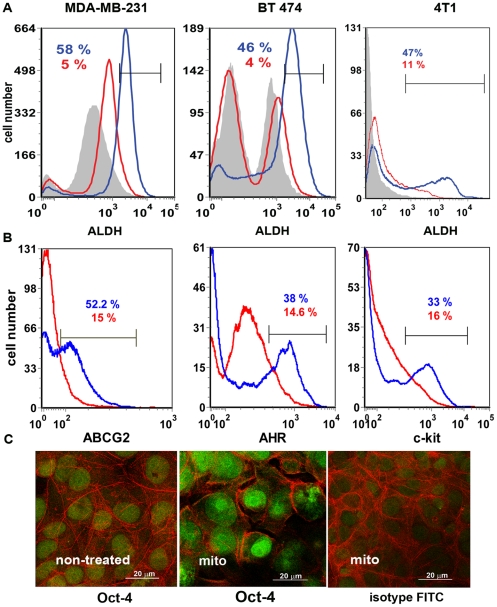
Drug-selected cells express higher level of stem cell markers.Phenotyping of mitoxantrone-selected cells. A. Cells from cell lines MDA-MB-231, BT474, or 4T1 were grown in mitoxantrone-containing medium to generate CSC-like cells (D-CSCs), as described in Materials and Methods. The cells were stained for ALDH-1 expression by the ALDEFLUOR assay. Silver-filled histograms represent negative control obtained in the presence of the ALDH-1 inhibitor DEAB, and were used for the gating of the ALDH-1 bright cells (ALDH high). In each histogram, blue lines and numbers (%) represent the percent of ALDH high cells in mitoxantrone-treated cells, while red lines and numbers (%) represent the percent of ALDH high cells in the non-treated cells. The figures show that mitoxantrone notably increased the number of ALDH1 high cells. B. MDA-MB-231 cells were stained for ABCG2, AHR, or c-kit and analyzed by flow cytometry. Mitoxantrone-selected cells (blue lines and numbers [%]) showed a marked increased in the expression of ABCG2, AHR, and c-kit, as compared to the non-selected cells (red lines and numbers [%]). The gates were positioned to include the peak of the brightest cells in each histogram. C. Drug selection increased the number of cells expressing the stem cell nuclear marker Oct-4 (green) in MDA-MB-231 cells, from ∼5% without mitoxantrone (non-treated) to ∼30% with mitoxantrone (mito), as detected by immunofluorescent confocal microscopy. The cytoplasm (red) was decorated with Alexa Fluor 568-conjugated phalloidin that binds to actin. The data in panels A and B are representative of two independent experiments.